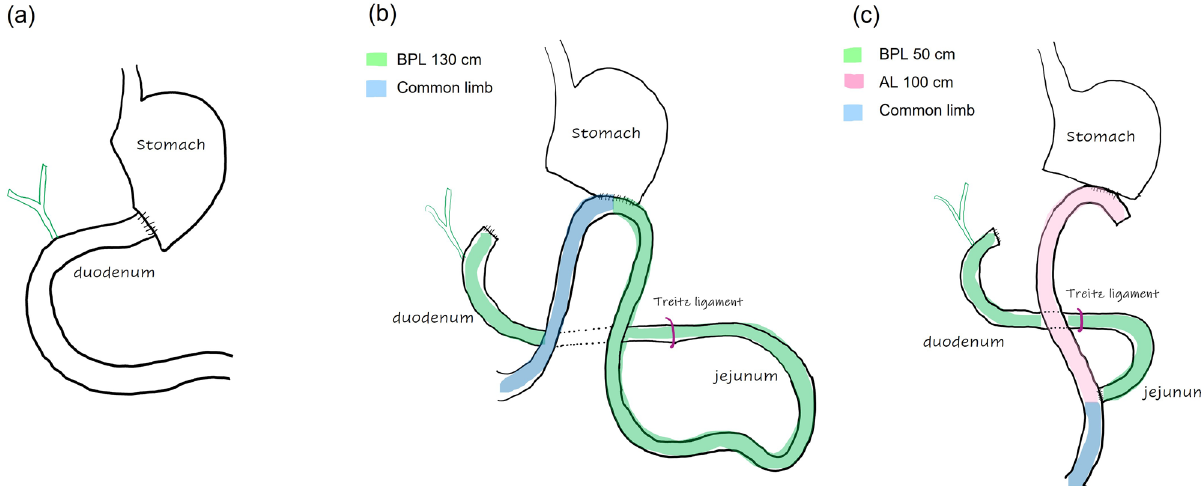
Figure 1. Schematics of the each reconstruction type. ( a ) Billroth I, ( b ) long-limb Billroth II, and ( c ) long-limb Roux-en-Y reconstruction ( BPL biliopancreatic limb, AL alimentary